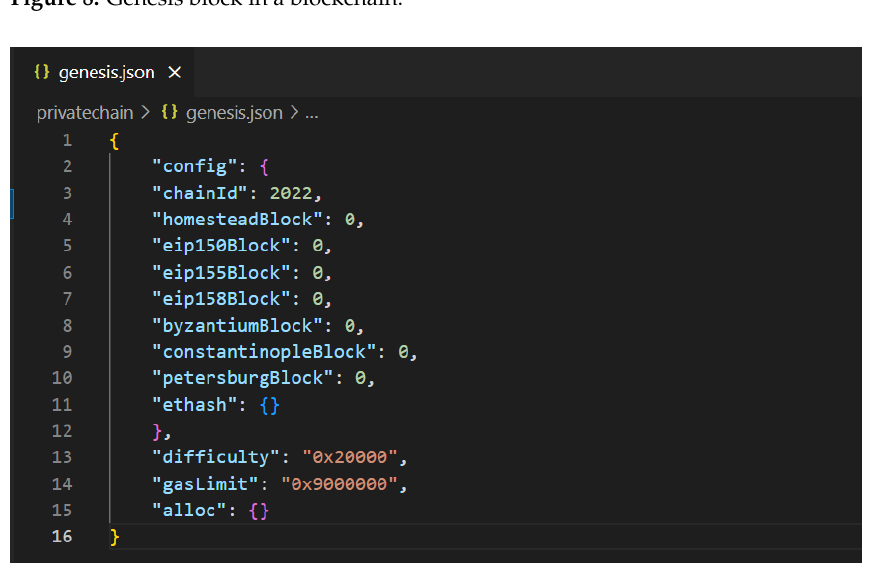
Figure 9. Genesis block